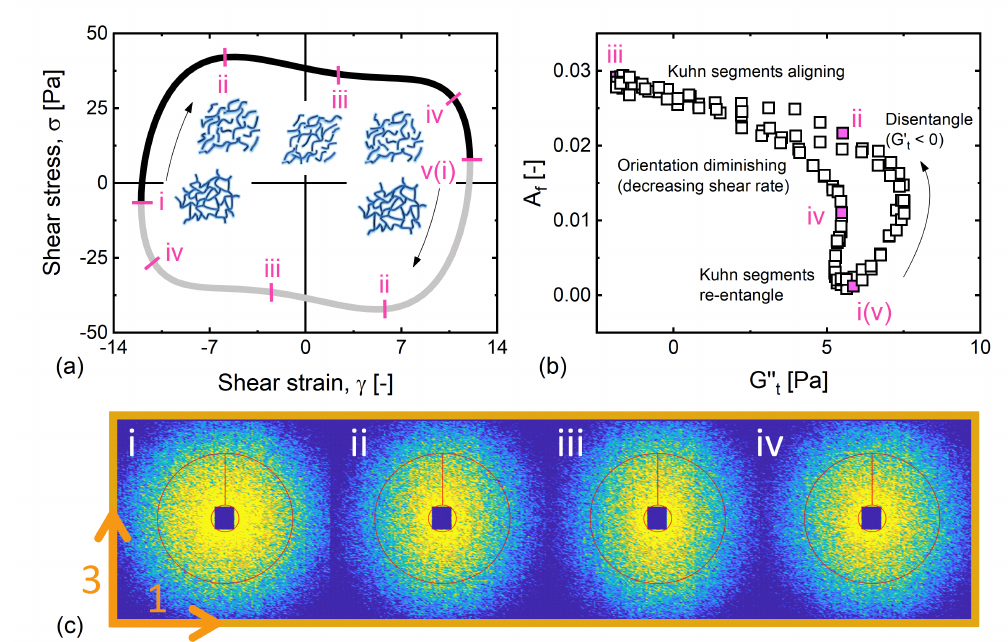
Figure 6. The microstructural evolution during the course of oscillation at De = 0.15. The structure evolves in a sequence: network disentangling in stages i–ii, Kuhn segments aligning in stages ii–iii, orientation diminishing with decreasing shear rate in stage iii–iv, and Kuhn segments re-entangling to form the initial quiescent network in stages iv–v. ( a ) Shear stress versus shear strain. ( b ) The degree of alignment is plotted as a function of time-dependent viscous modulus. ( c ) 2D SANS patterns in the corresponding stages during a LAOS